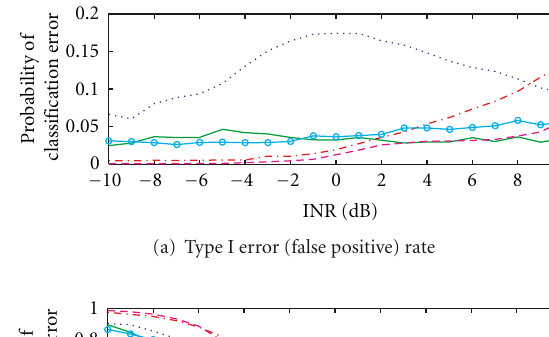
Figure 6: An example interference classification produced using power spectrum analysis. The classification should be compared against reference sample vector interference spectrum shown in Figure 2. In this example, this method failed to detect the low power interferer occupying frequency bins 64 through to 77, but otherwise produced an accurate classification.